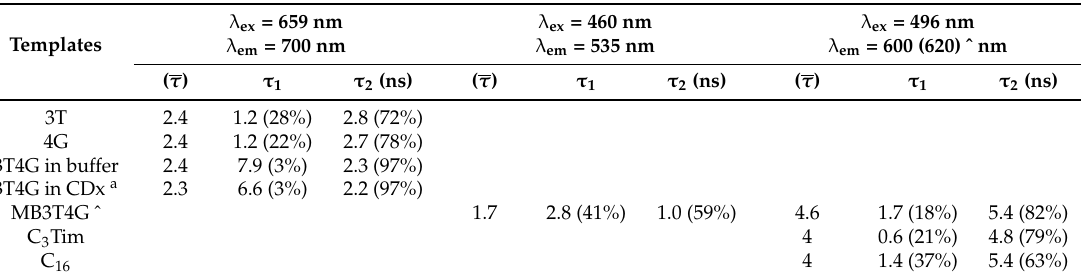
Fluorescence decay parameters of the silver nanocluster species formed on the 15 µ M single stranded DNA templates ([DNA]:[Ag] = 1:6) with the repeated base sequence 5 1 -C 3 X i C 3 X ii C 3 X iii C 3 X iv -3 1 where i, ii, iii, iv correspond to T/G/C deoxynucleobases (with default base X = A) in 10 mM citrate buffer of pH